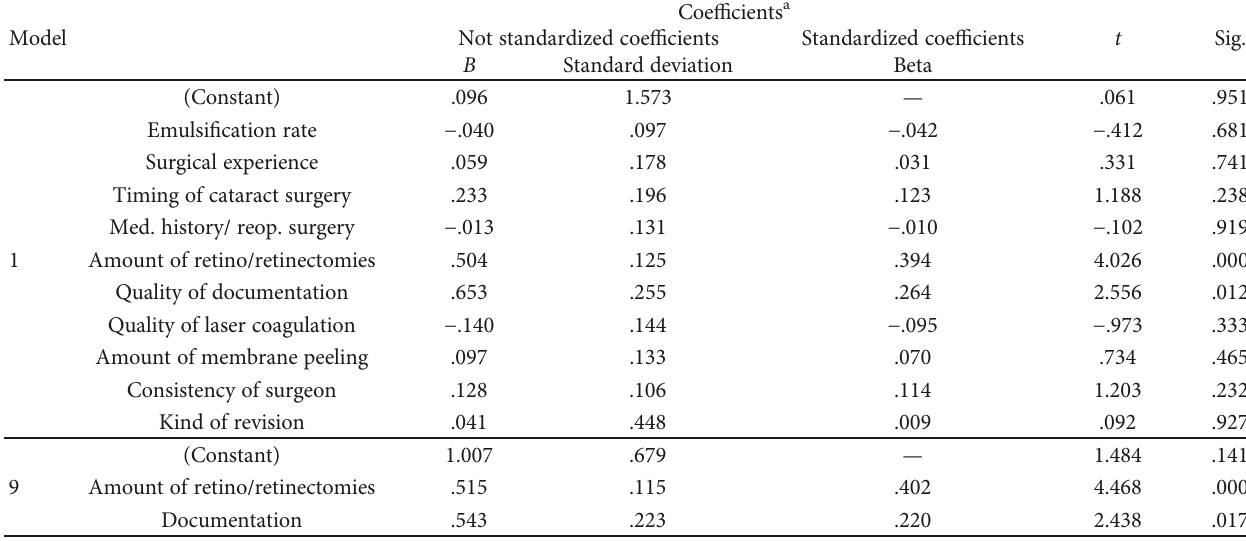
Table 5: Multiple regression to analyse potential risk factors for retinal redetachment rate in the prospective group: in this group, all patients got a 3-port revision surgery, so that “ kind of revision ” was not a predictor in this model.